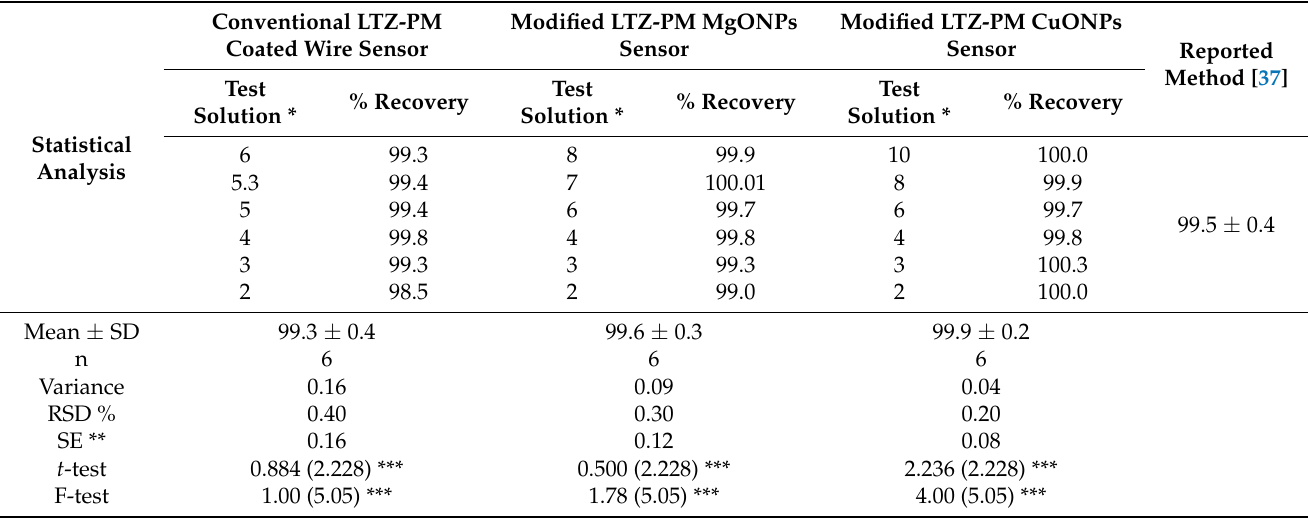
Table 5. The outcomes from the determination of LTZ in Femara ® (2.5 mg Letrozole/tablet) using fabricated LTZ-PM, modified LTZ-PM-MgONPs and LTZ-PM-CuONPs coated wire sensors in comparison with previously reported method [37].